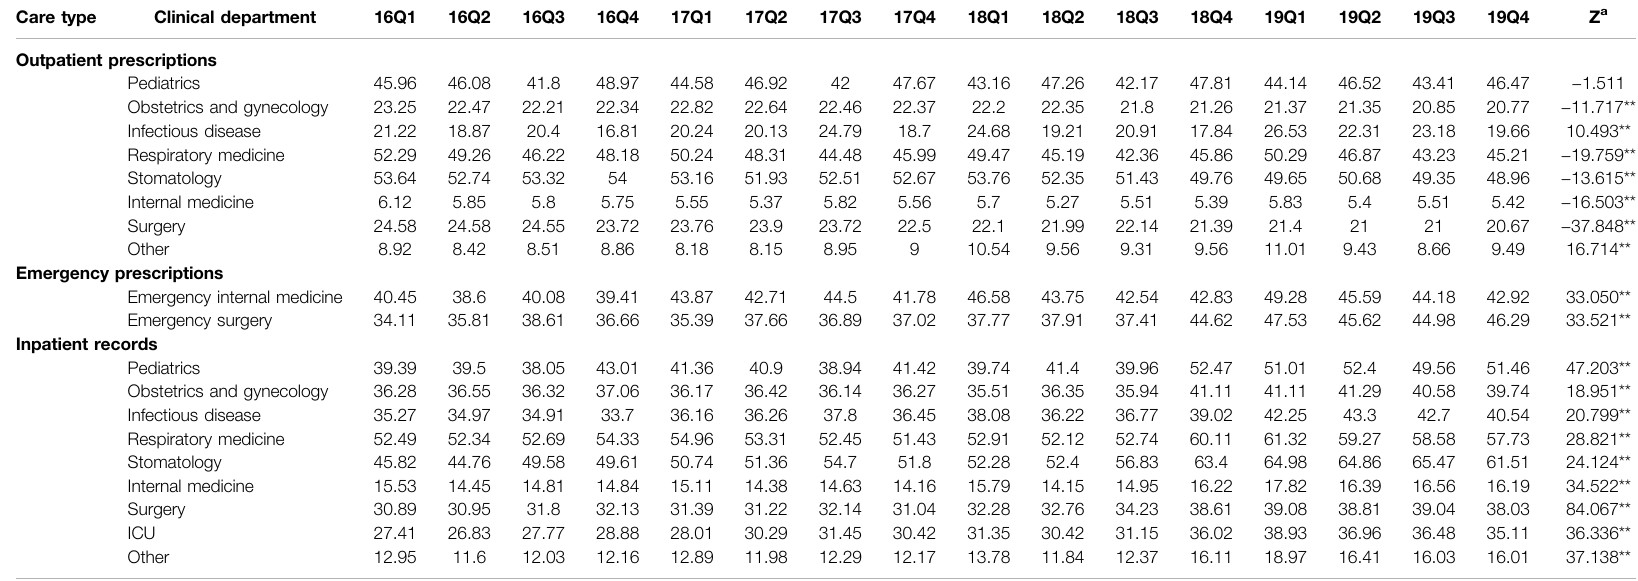
TABLE 2 | Changes in proportion of treated with antibiotics in different clinical departments, 2016 – 19. Care type